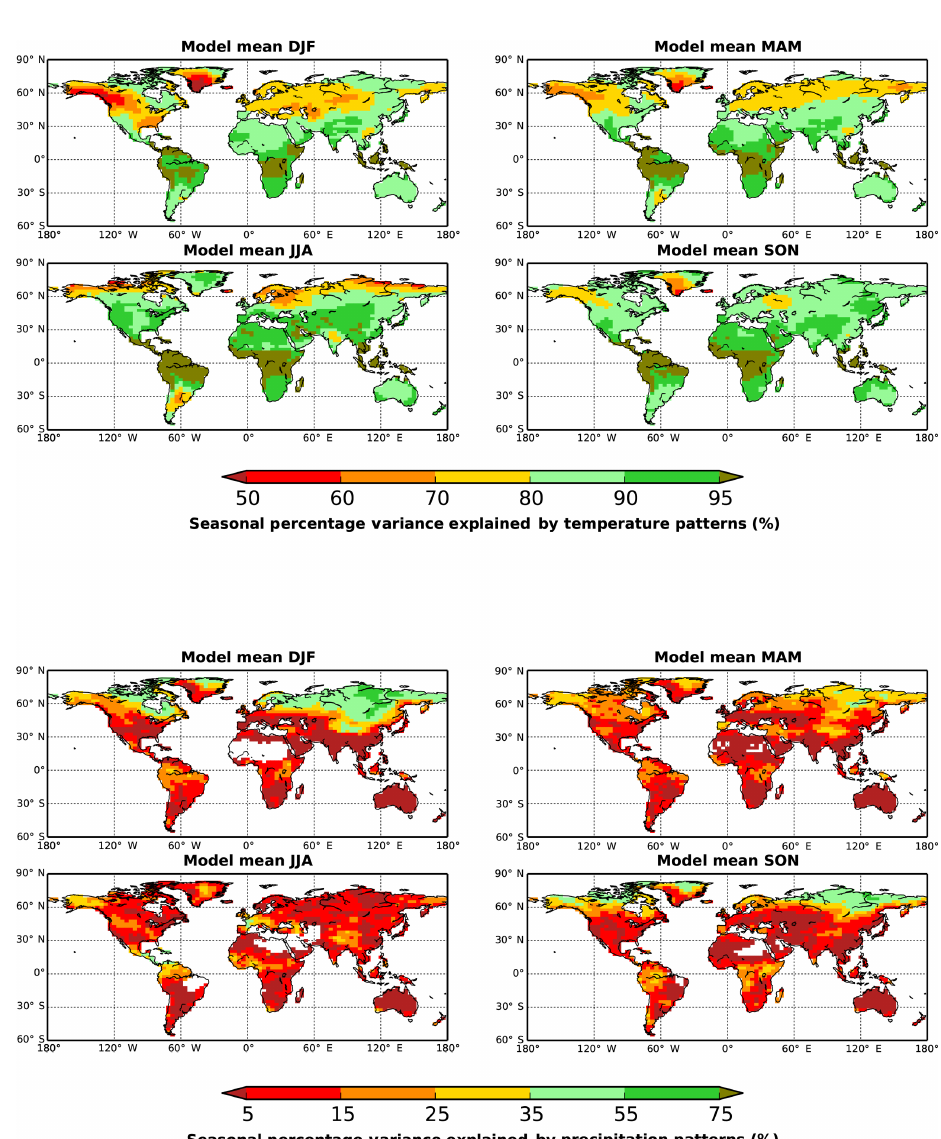
Figure 6. Seasonal percentage of variance explained of the monthly patterns of local temperature and precipitation change per degree warming, across 22GCMs. DJF is December, January and February; MAM is March, April and May; JJA is June, July and August; and SON is September, October and